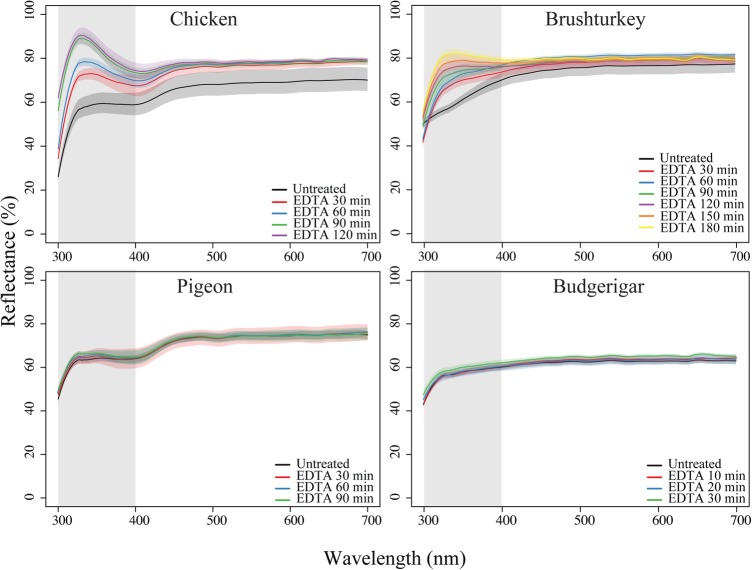
The effect of EDTA treatment on diffuse reflectance of white-coloured eggshells from chicken, brushturkey, pigeon and budgerigar. Durations for EDTA treatment were different for budgerigar, as the eggshells were very fragile. Plotted lines are group mean spectra (n=3) with shaded areas representing the standard error. Grey area represents the UV-region, highlighting differences in reflectance.